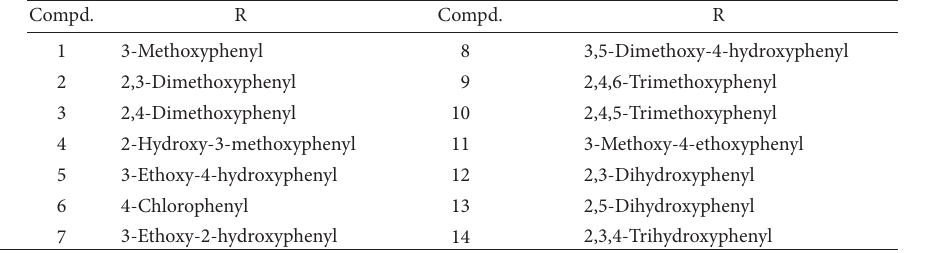
Scheme 1: Synthetic route for the synthesis of compounds (1–14).